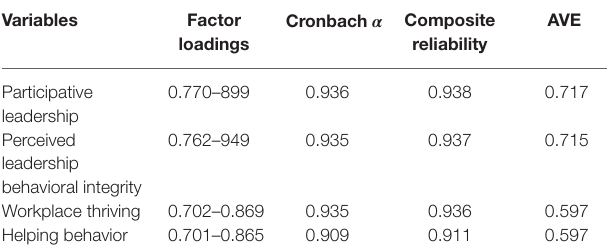
TABLE 1 | Measurement analysis